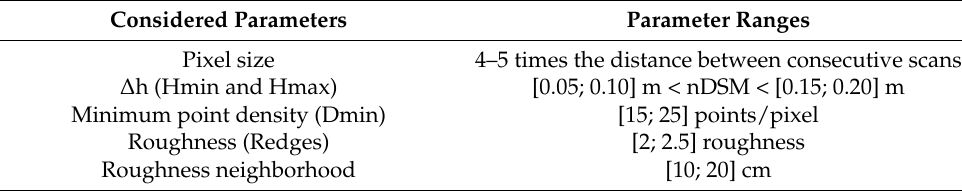
Table 5. Range of values for every considered parameter and quantitative analysis for different parameter configurations.